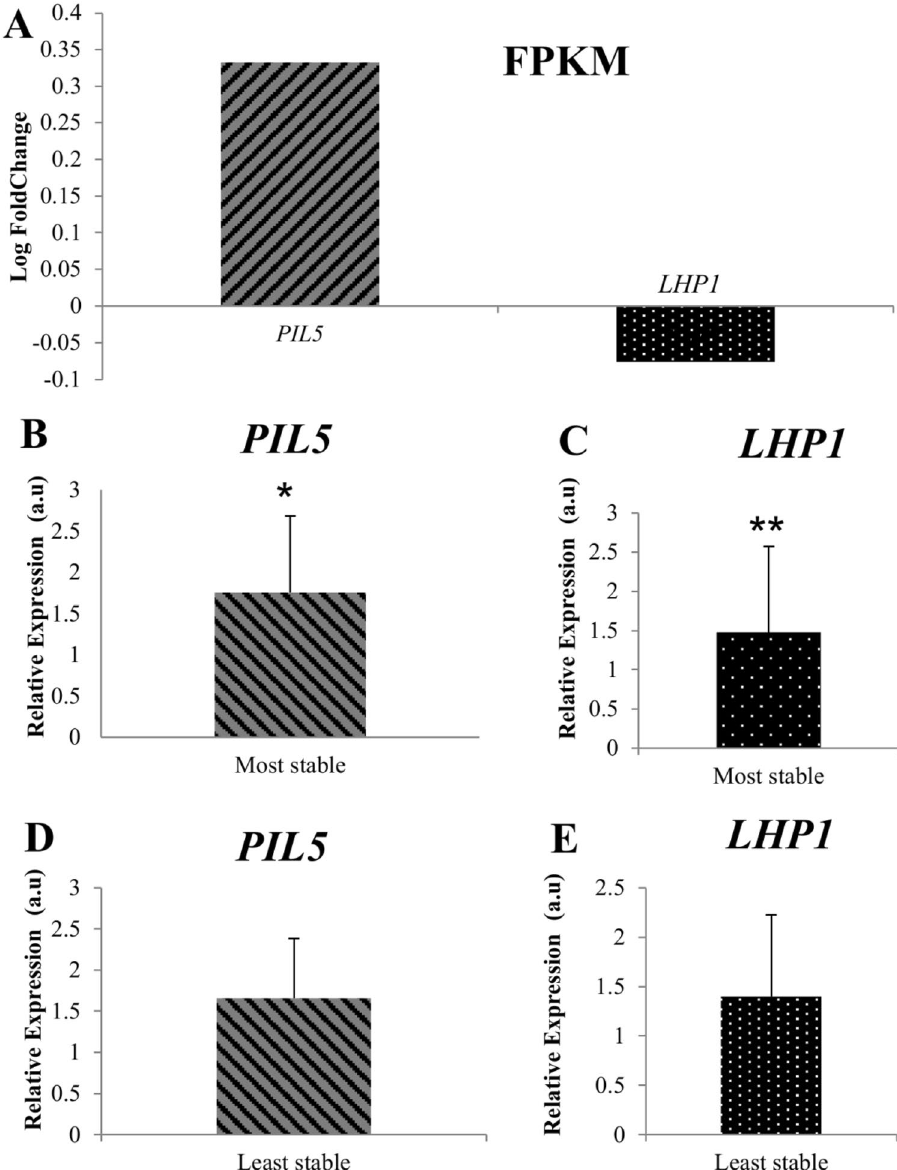
Figure 2. Relative expression data versus FPKM data in mature leaf 7th time point. FPKM results are represented by average from six libraries from RNA-Seq assay ( n = 3) converted in log fold change SD/LD ( A ). Target genes normalized with the most ( B , C ) and least stable ( D , E ) reference gene pairs, the error bars, represent standard error. a.u: arbitrary units. For statistical analysis of expression levels in SD compared to LD: P < 0.001 (***), P < 0.01(**), and P <